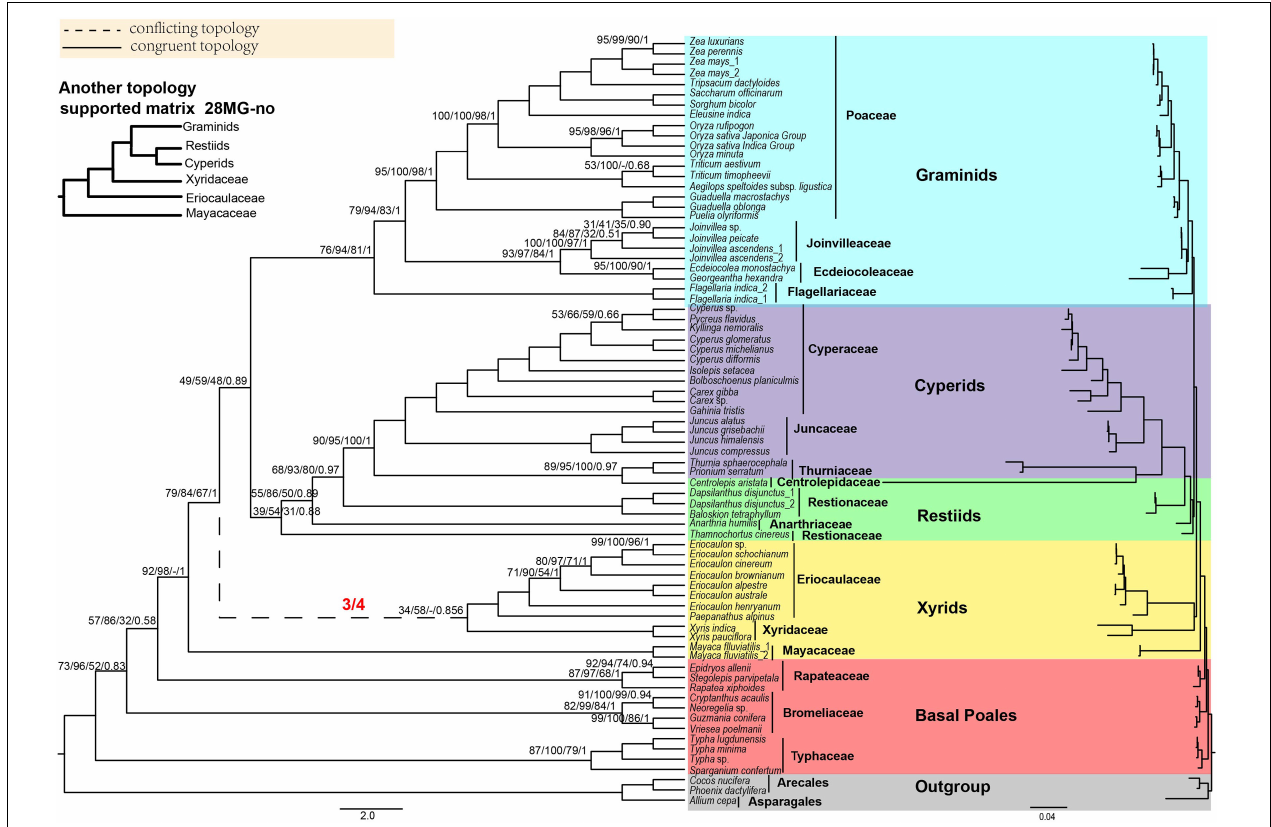
FIGURE 2 | The Poales phylogeny based on 28 mitochondrial genes (28MG). The red fractions on the branches represented by dotted lines indicate the supported numbers in the four matrices. Support values are given above branches with the order MLBS values/UFBS values/MPBS/PP values/LPP values. Support values are displayed for branches with less than 100% BS support, less than 1.00 for posterior probability, or less than 1.00 for local posterior probability. The conflicting topologies are shown by “–”. The clades are shown in different colors in Figure 1 . The top left corner shows another topology that is different from the 28 MG matrix of xyrids recovered in the corresponding matrix. Note: -no mean that using Gblocks that allow gap positions with